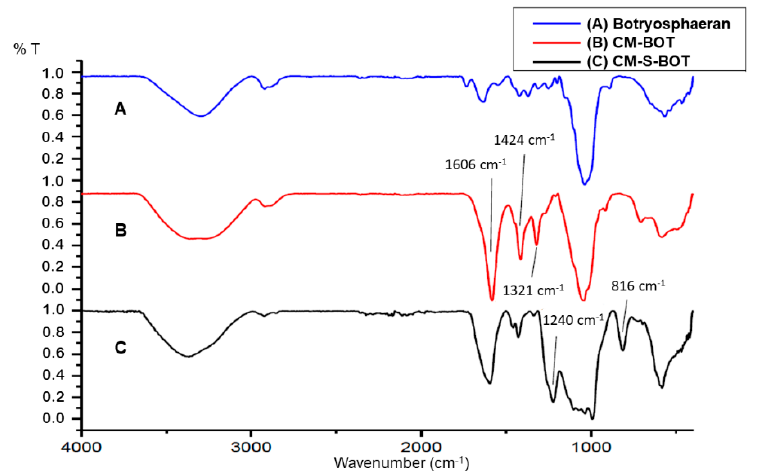
Figure 2. Comparison between FT-IR spectra of BOT ( A ) and its carboxymethylated ( B , CM-BOT) and sulfated/carboxymethylated ( C , CM-S-BOT) derivatives.